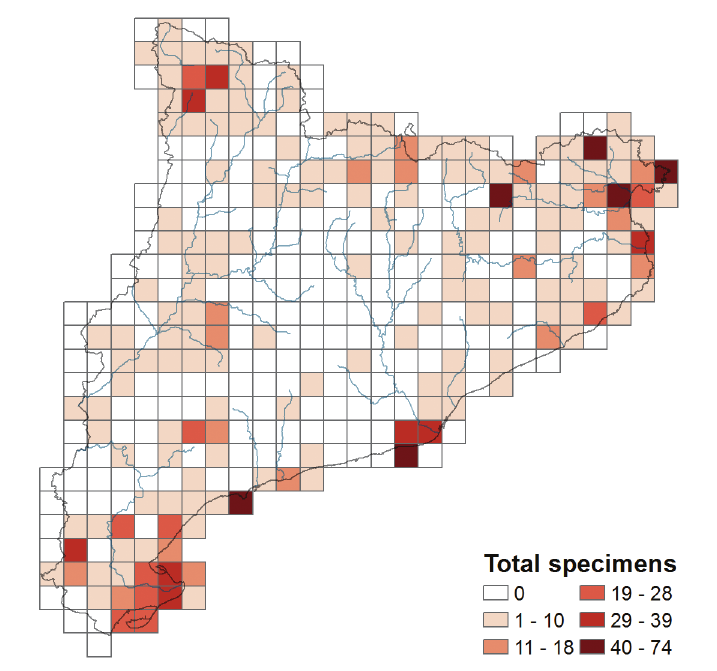
Figure 4. Distribution map of the number of specimens for UTM grid of 10 km 2 Table 6. Number of specimens and taxa of the most prospected areas, with more than 40 specimens. Dataset UTM (regions) Catalonia Red Book Spec.